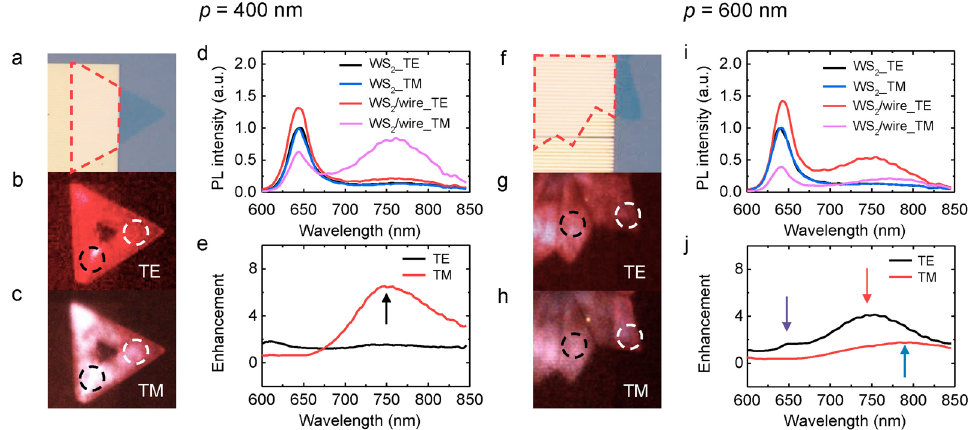
Figure 2. Anisotropic enhancement of the PL emission in WS 2 -Ag wire hybrid nanostructures. ( a ) Optical image of the hybrid nanostructure. WS 2 covered by the nanowire array ( p = 400 nm, w = 140 nm) is enclosed by the red dashed lines. ( b )–( c ) The corresponding PL images for TE and TM polarizations. The dashed circles indicate the positions of the spectral measurement. ( d ) Normalized PL spectra of the WS 2 bilayer with (red and pink curves) and without (black and blue curves) silver nanowire array for TE and TM polarizations respectively. ( e ) PL enhancements of the hybrid nanostructure relative to the pristine WS 2 for TE (black curve) and TM (red curve) polarizations, respectively. ( f )–( j ) The corresponding results for the hybrid nanostructure with p = 600 nm and w = 300